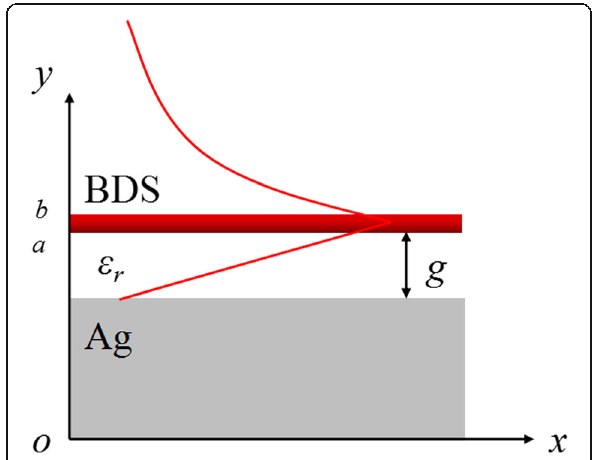
Fig. 1 Schematic illustration of the BIM plasmonic waveguide: a monolayer BDS film is placed at a gap width g away from the silver substrate separated by a dielectric spacer with permittivity ε r . The TM-polarized plasmonic waveguide mode propagates along the x direction and decays along the y direction. Schematic depiction of the E x distribution is depicted by the red